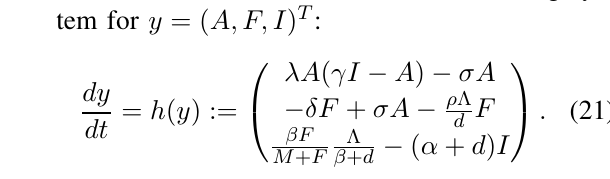
P ARAMETER VALUES USED IN F IGURE 4